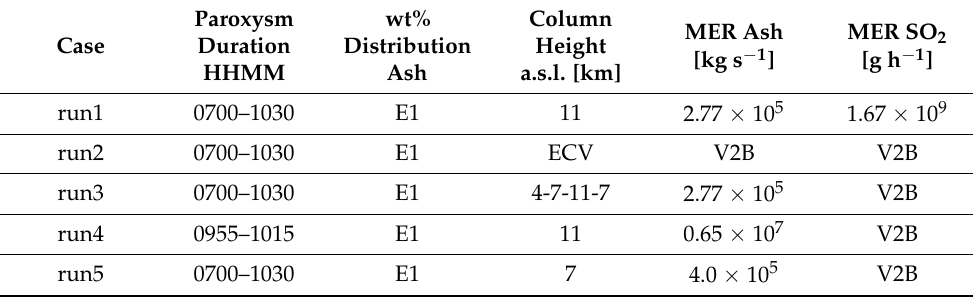
Table 2. Eruption source parameters and WRF-Chem chemistry option. ECV and V2B indicate time-varying MER retrieved from the VOLDORAD-2B radar (Figure 3) and plume heights retrieved from a video camera (Figure 4),